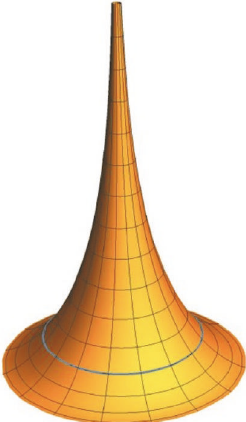
Figure 3: Upper half of a tractricoid (pseudosphere). The horocycle of length one is drawn in light blue. It separates the half tractricoid into a cusp (upper part) and a portion of a horn (lower part). The latter is bounded by a horocycle of length 2𝜋